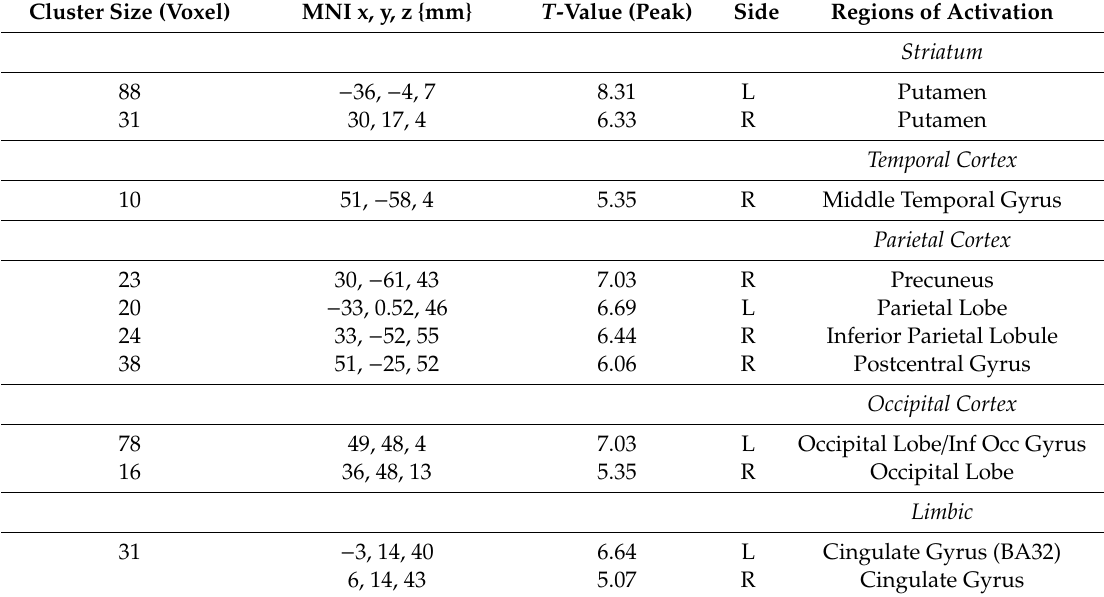
Table 6. PPI analysis for Familiar CS > Novel CS 1